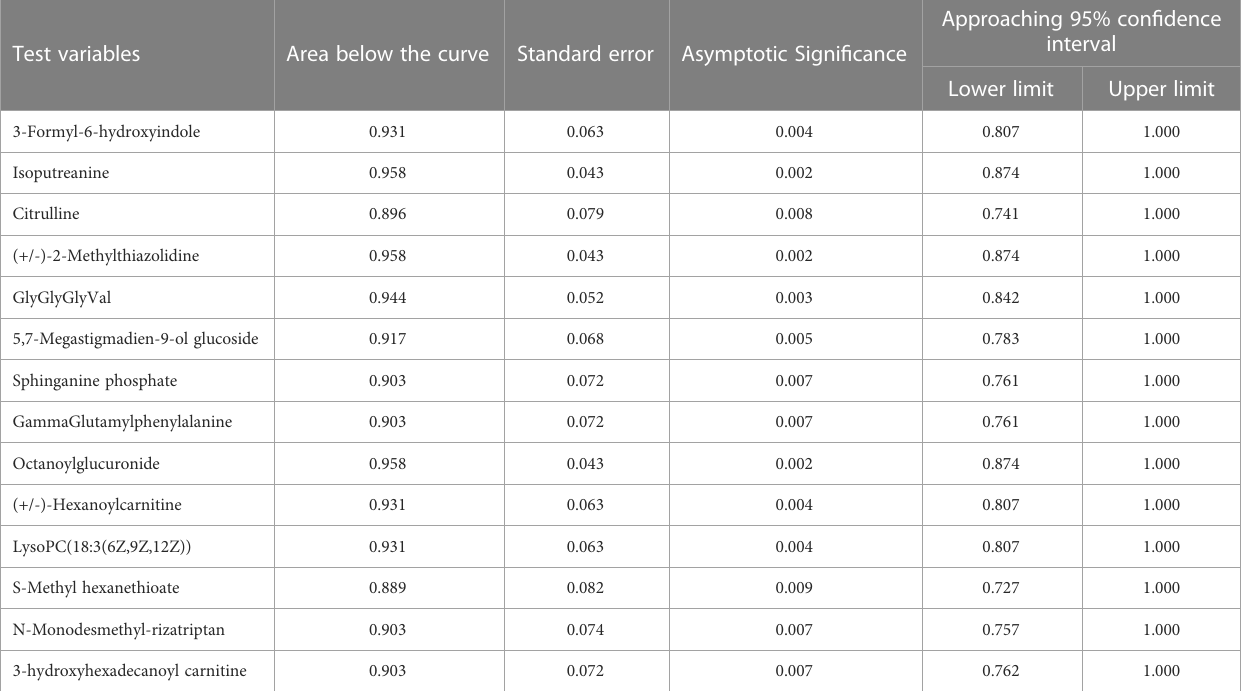
TABLE 3 Area below the curve for 14 differential